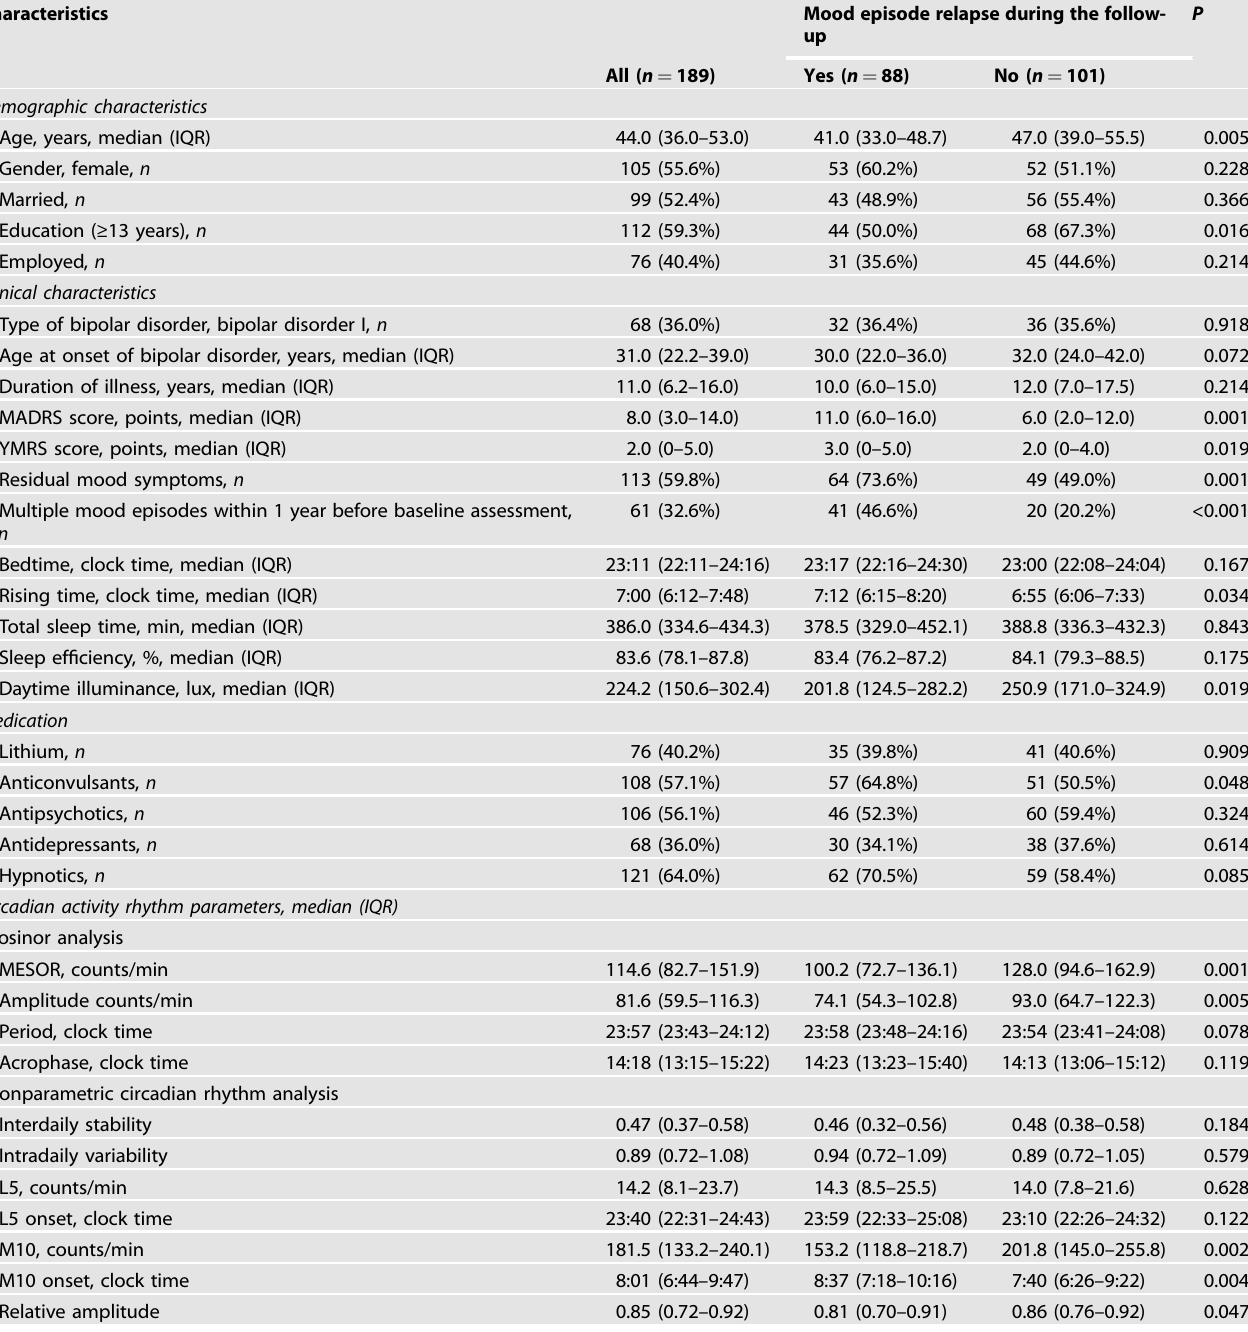
Table 1. Baseline characteristics of the 189